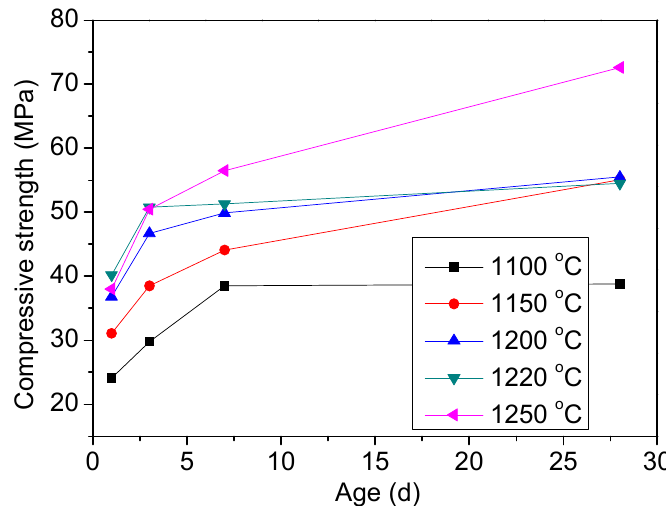
Figure 6. Compressive strength of cement clinker B sintered at different temperatures.